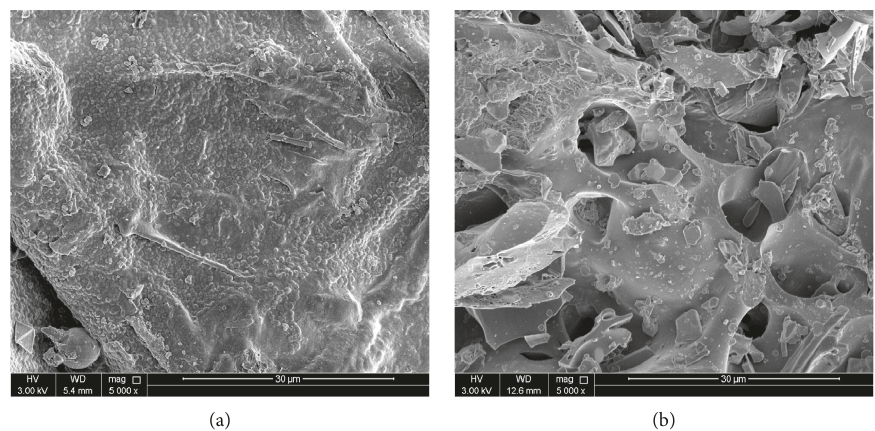
Figure 10: SEM micrographs at 5000x magnification power for (a) RPP and (b) BPP.